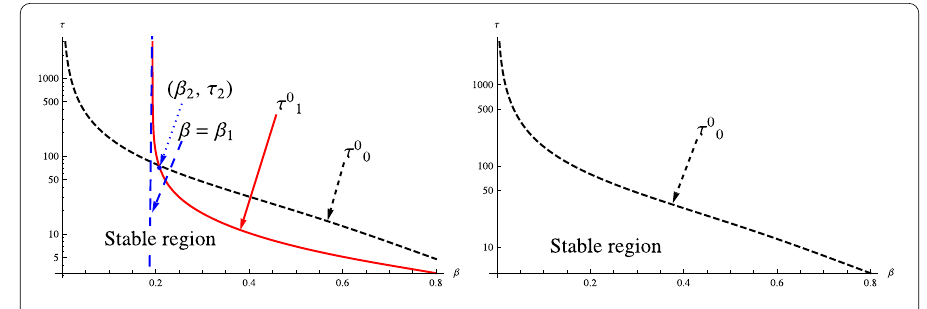
Figure 1 Bifurcation diagram of system (1.4) for β and τ . (Left: model (1.4). Right: model (2.9))